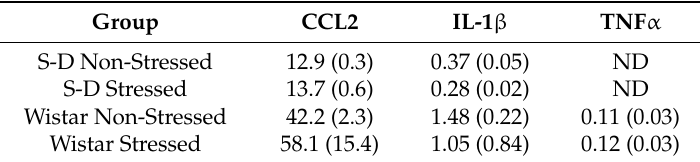
Table 1. Effect of acute stress on cytokine proteins in